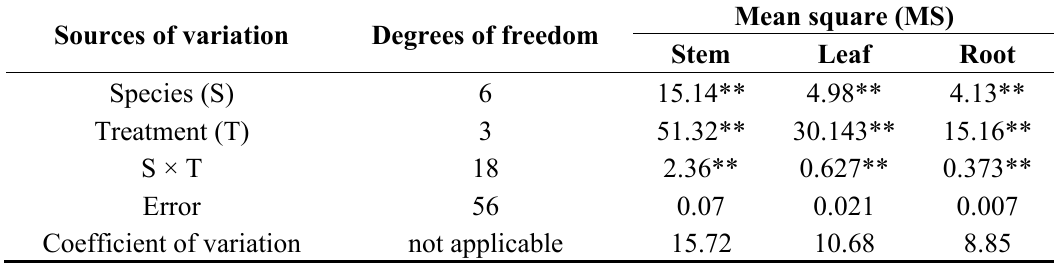
Table 5. Variance analysis of the investigated characteristics in studied species.